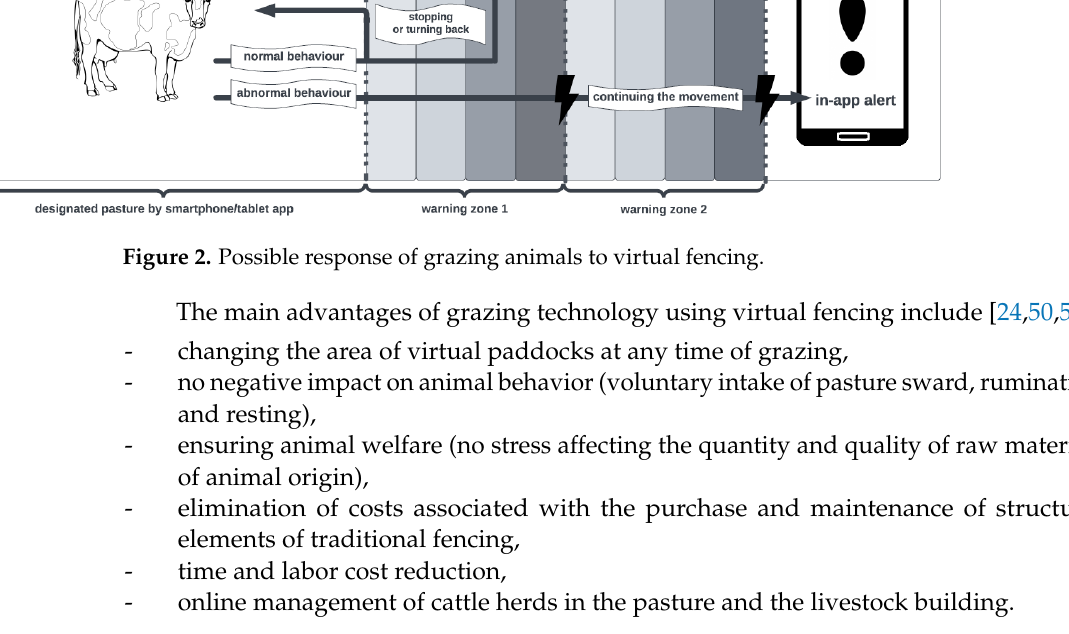
Figure 1. General concept of virtual fencing for grazing animals.